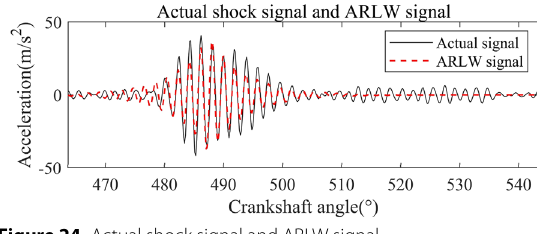
Figure 24 Actual shock signal and ARLW signal